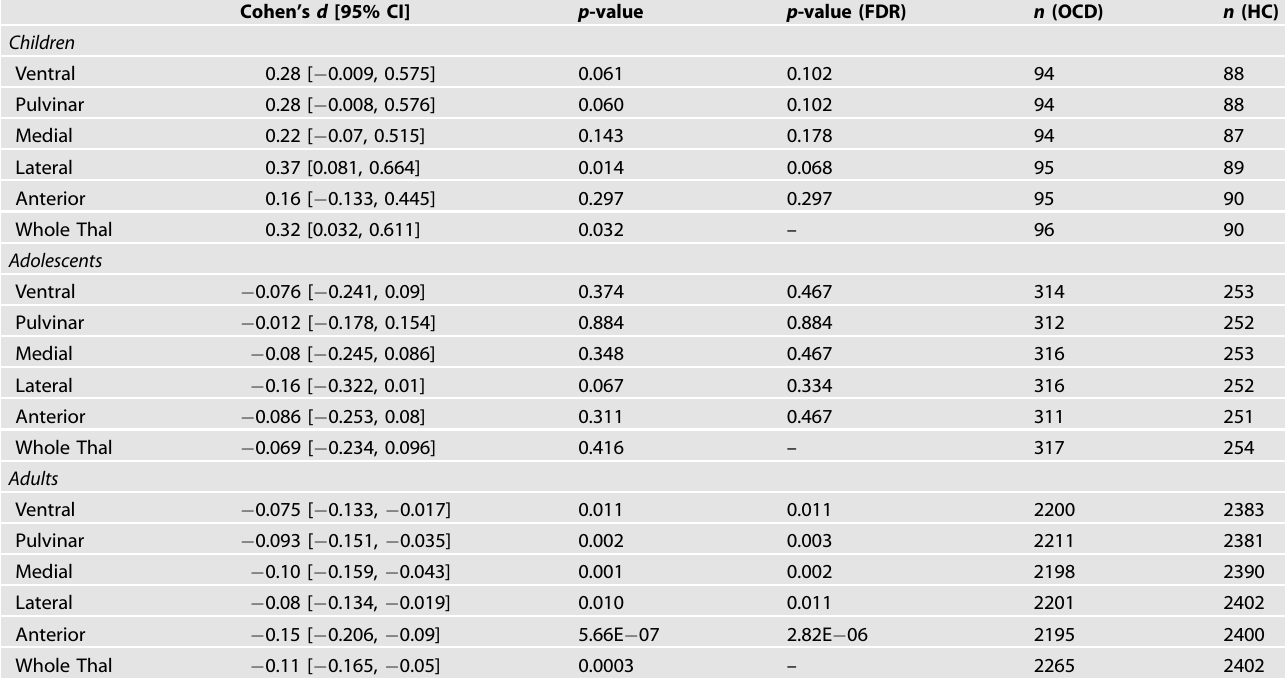
Table 2. Multiple linear regression output of volumetric difference between obsessive-compulsive patients and healthy controls for children (<12 years), adolescents (12 – 17 years) and adults (age 18 or